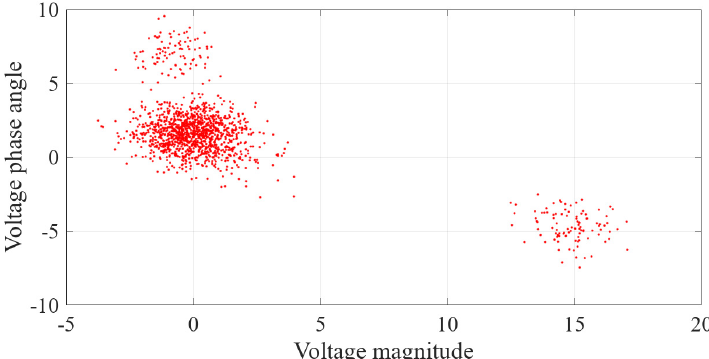
Figure 20. Errors of state estimation after false data